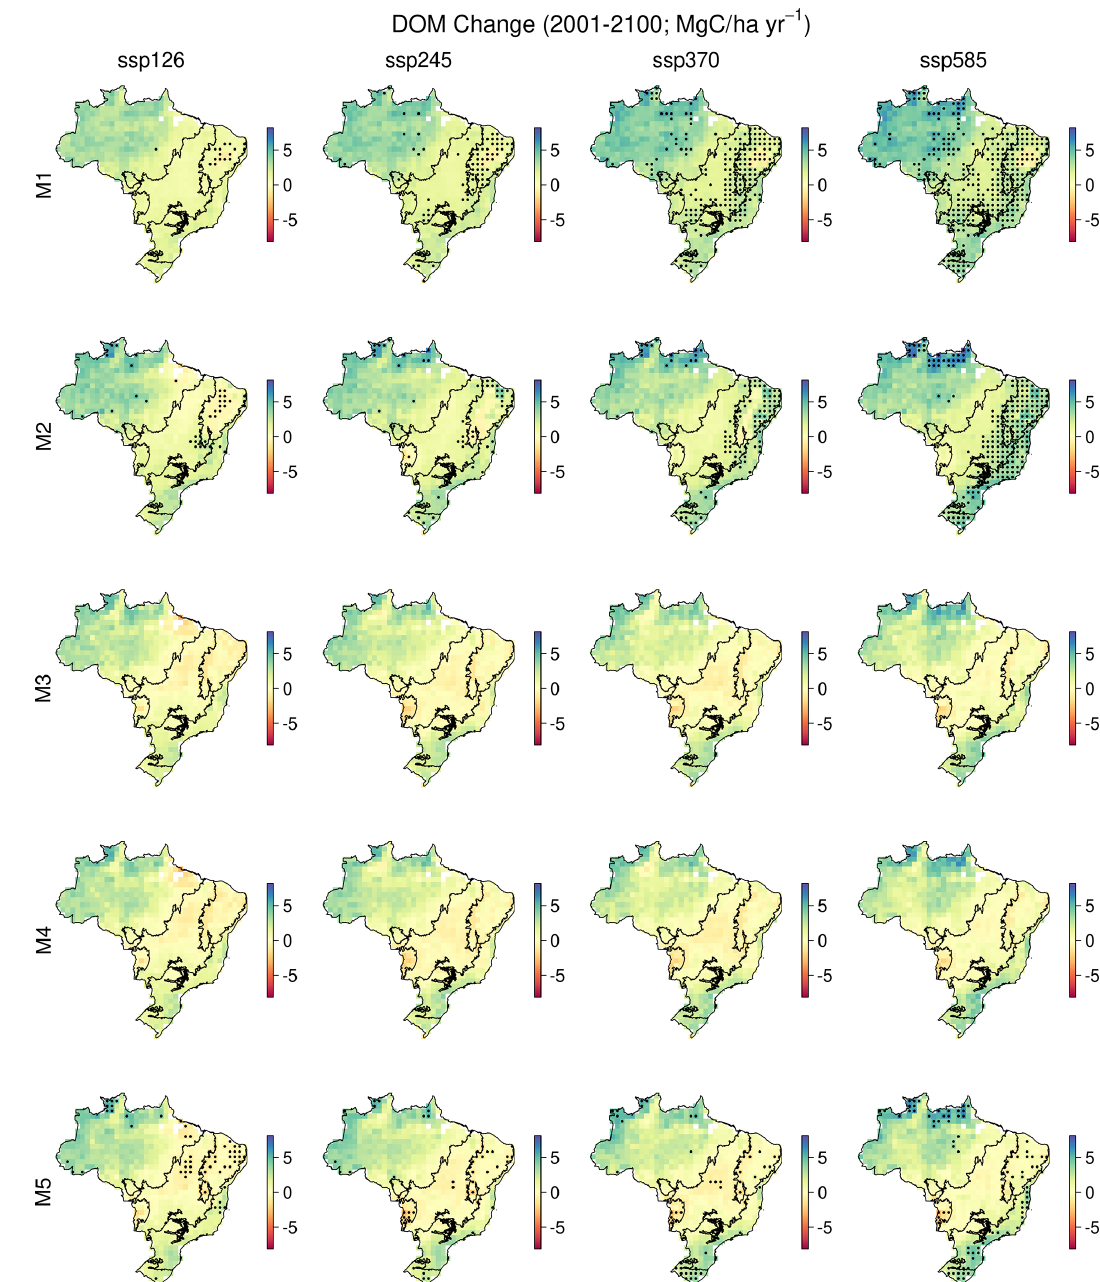
Figure A16. Maps of DALEC model estimates DOM (sum of soil, litter and in M5 wood litter) change between 2001 and 2100. The mapped values are estimated from the pixel-level median estimates. Areas with DOM change with > 90% confidence are shown with stippling.